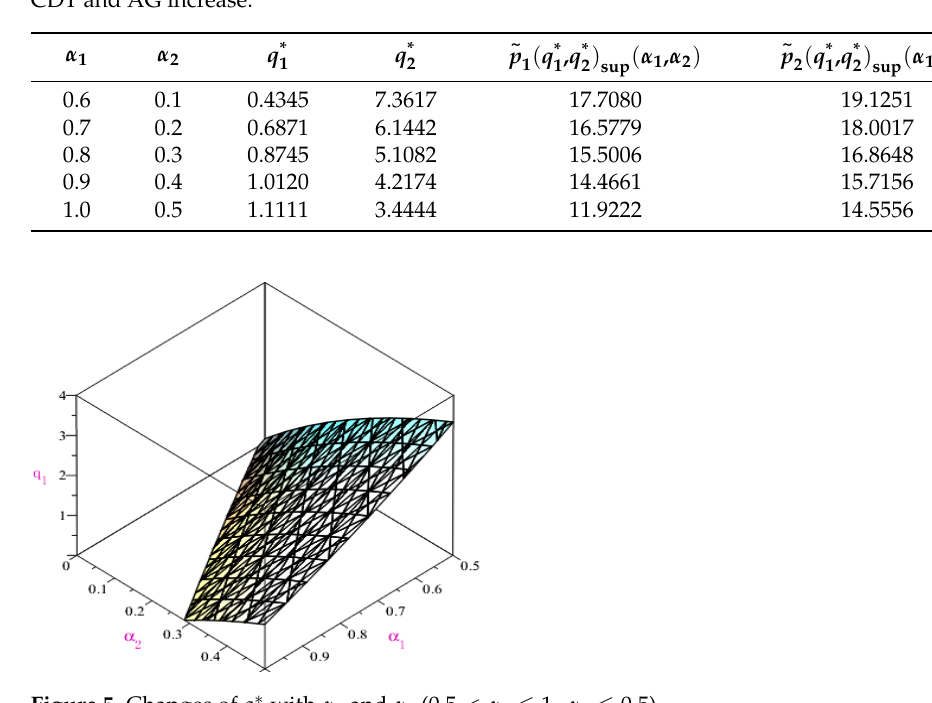
Figure 6. Changes of